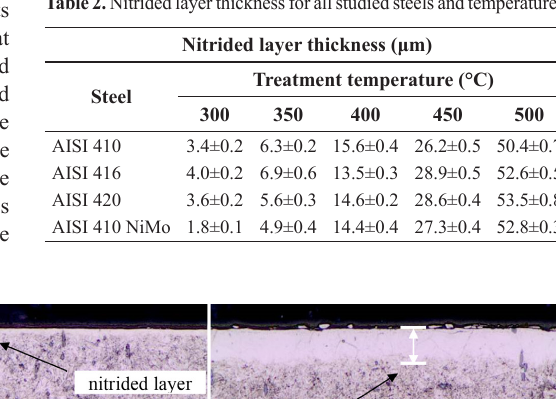
+20% H +10% Ar, at a flow rate of 3.33×10 6 Nm 3 s −1 and pressure of 3 Torr. 2 2